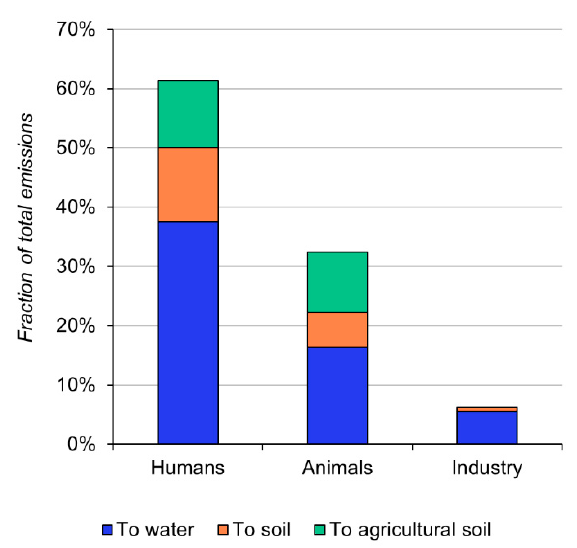
Figure 5. Fraction of total nutrient emissions stemming from humans and animals in towns with more than 5000 inhabitants and industry (slaughterhouses and dairies) to water, landfill and agricultural soil in 1900.